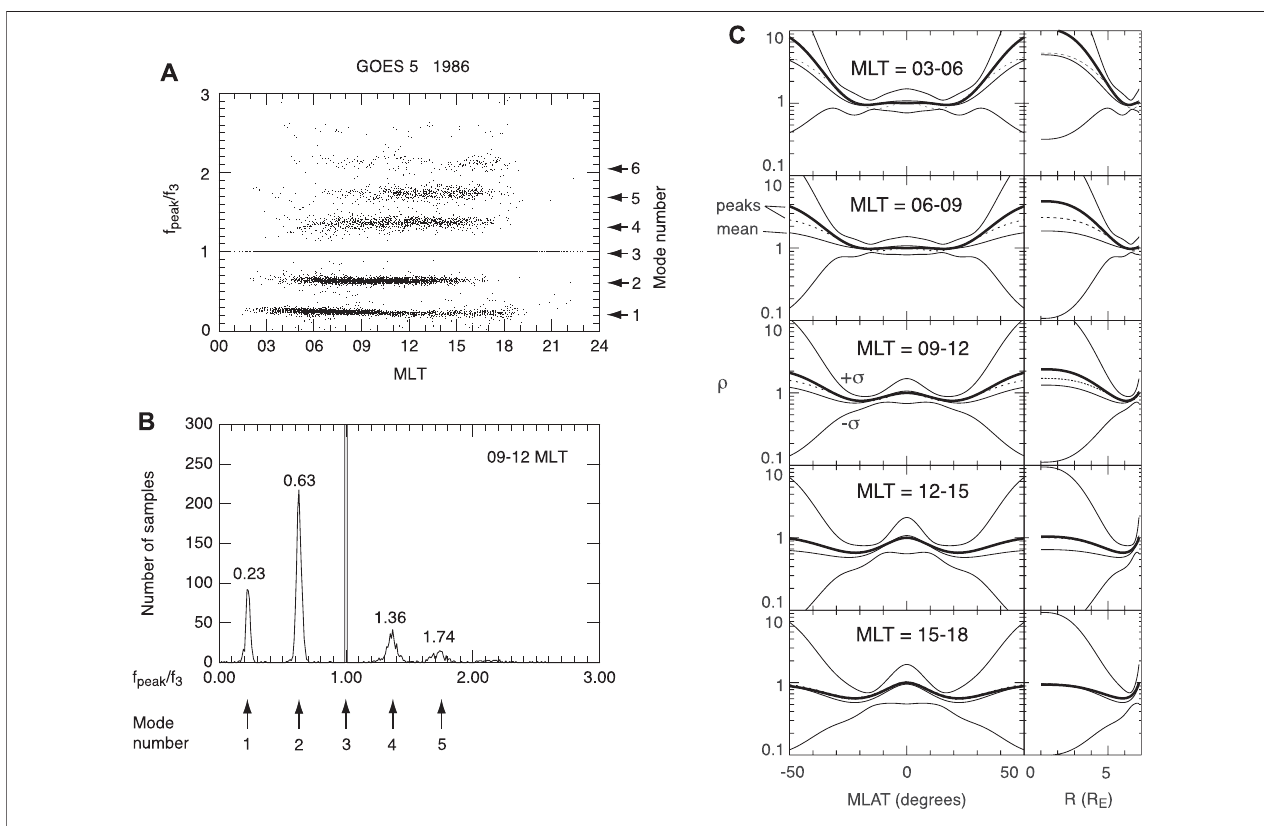
FIGURE 3 | Results of GOES magnetic fi eld data analysis (after Takahashi and Denton, 2007). (A) Frequencies at the peak of B ϕ power spectra normalized to the frequency of the third harmonic ( f 3 ). (B) Histogram of the normalized frequencies for 0900 – 1200 MLT. (C) Field line mass density distribution models in different MLT sectors. The mass density on the GOES magnetic fi eld line isplotted as a function ofboth MLAT (left column) and geocentric distance, R , to the fi eld line (right column)